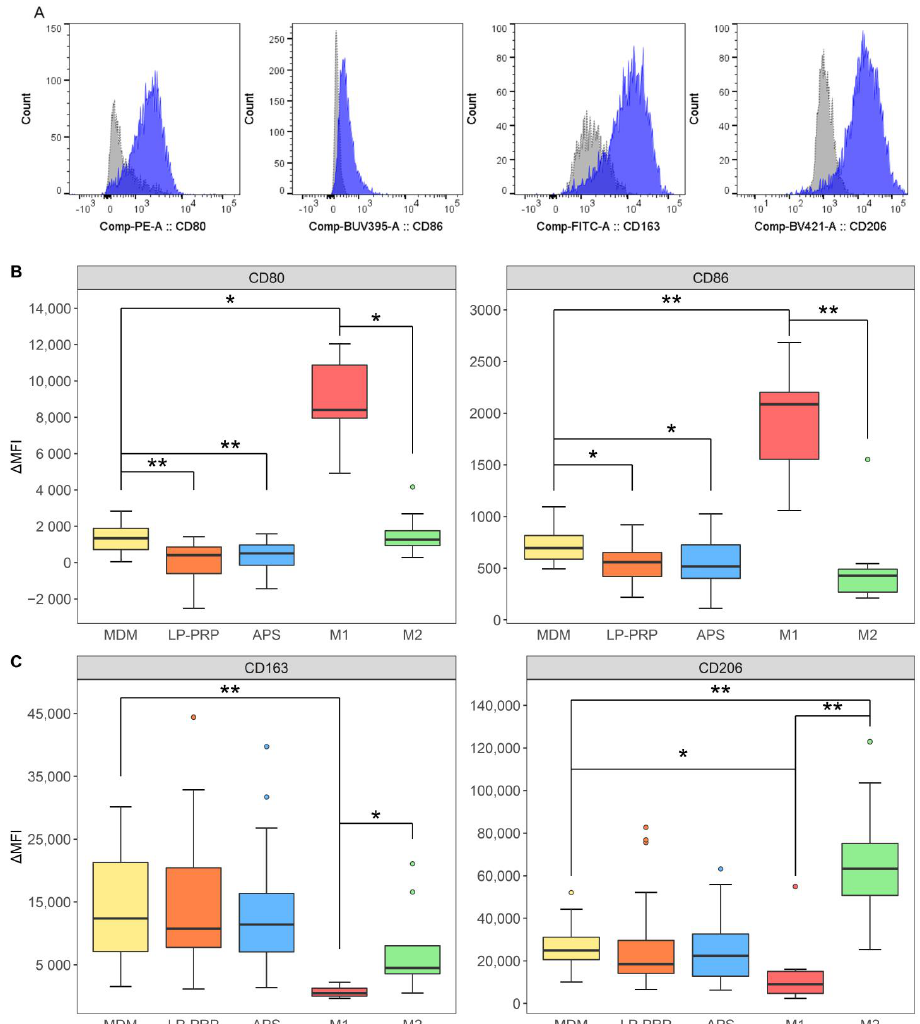
Figure 4. Flow cytometric analysis of M1/M2 macrophage cell surface markers. Cells were cultured under the same protocol as Figure 3. ( A ) A histogram representation of typical flow cytometry results. Gray and dashed lines: isotype control; blue and solid lines: signals for each antibody. Mean fluorescence intensity (MFI) values of each antibody were used to calculate ∆ MFI values: ∆ MFI = MFI Sample—MFI Isotype. ( B ) M1 macrophage markers. ( C ) M2 macrophage markers. MDM control group served